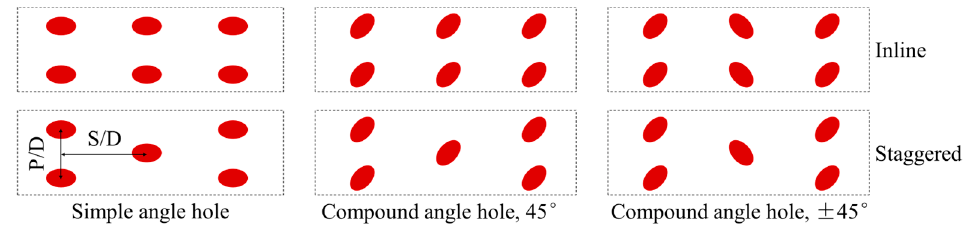
Figure 9. Effusion cooling configurations with different hole arrangements and hole